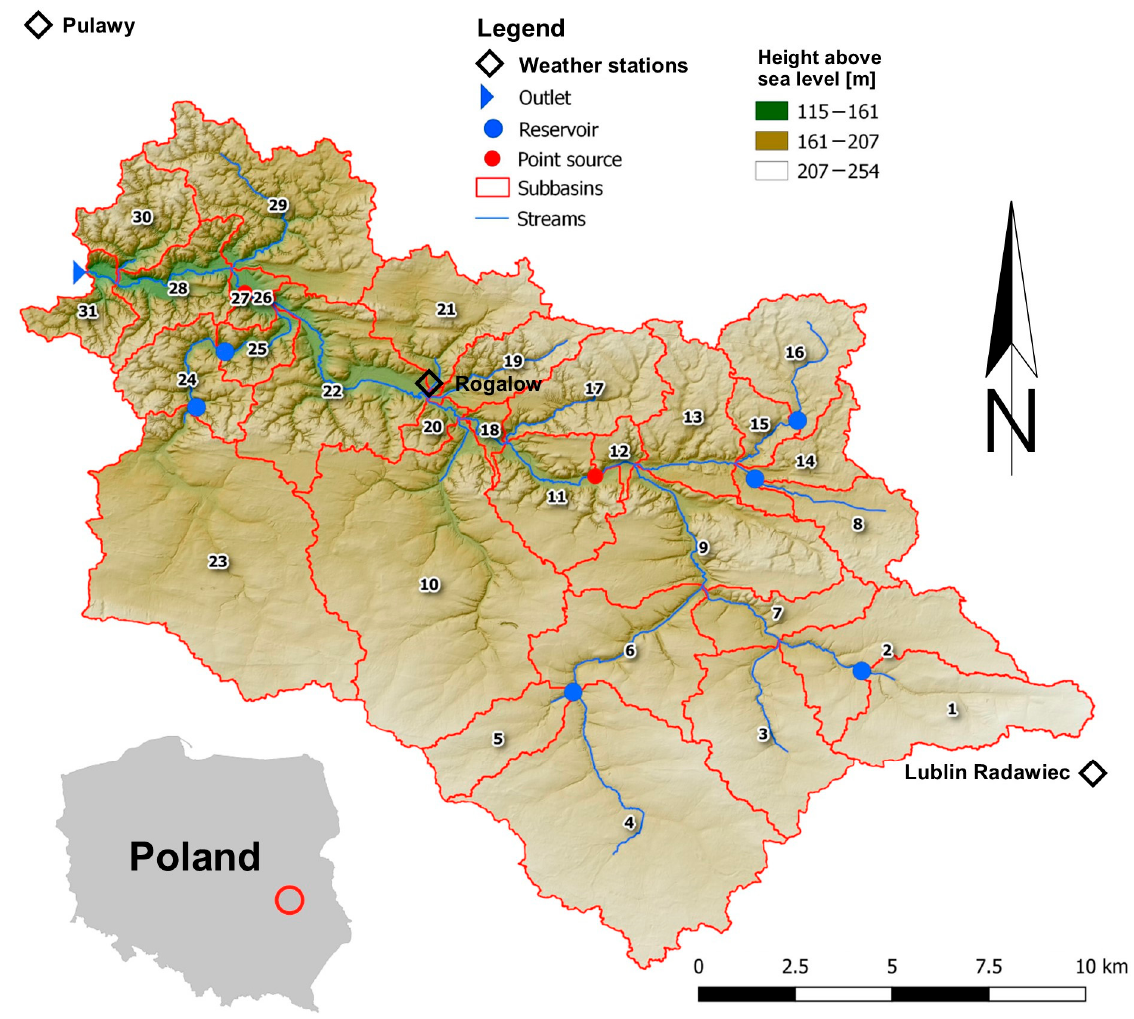
Figure 1. The catchment area of the Bystra River [28].